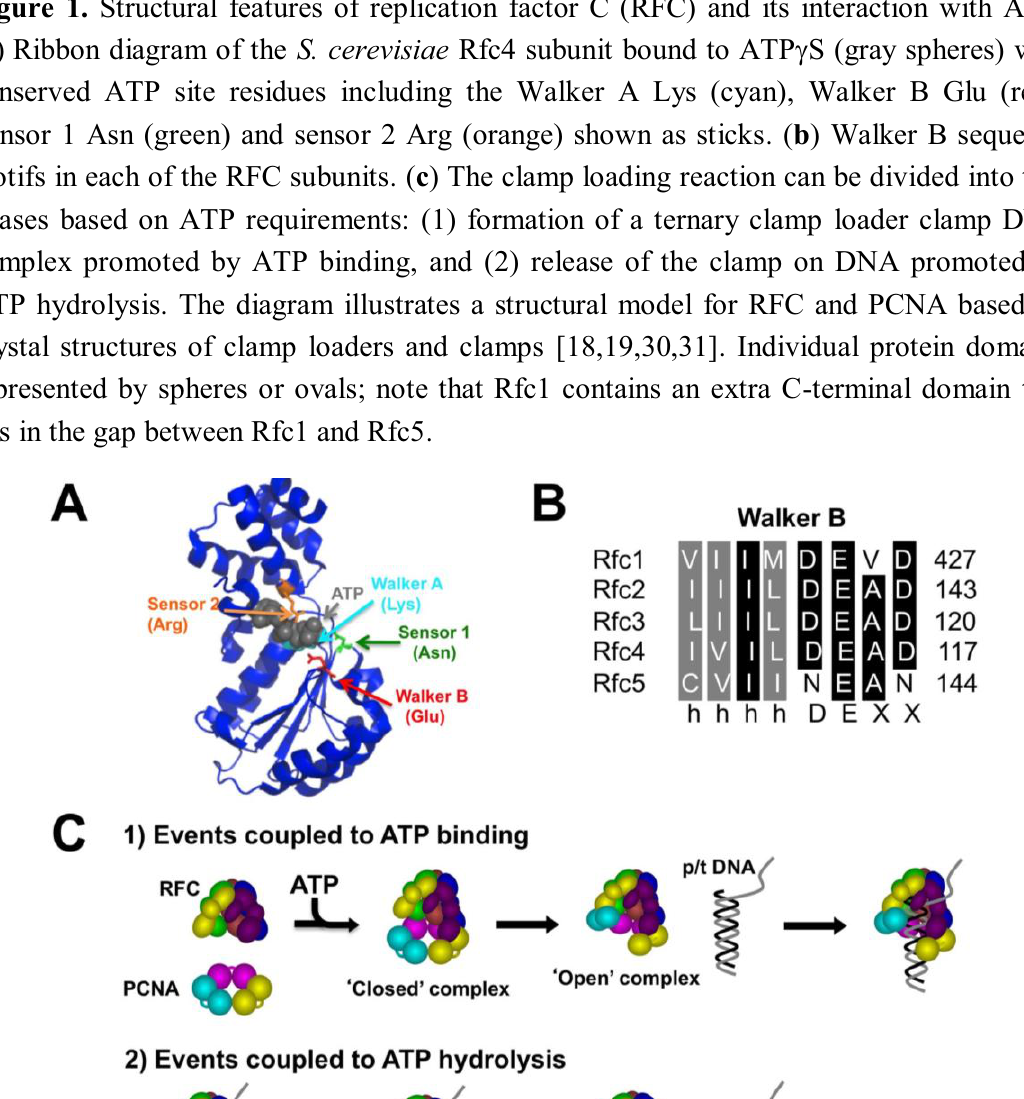
Figure 1. Structural features of replication factor C (RFC) and its interaction with ATP. ( a ) Ribbon diagram of the S. cerevisiae Rfc4 subunit bound to ATP (cid:74) S (gray spheres) with conserved ATP site residues including the Walker A Lys (cyan), Walker B Glu (red), Sensor 1 Asn (green) and sensor 2 Arg (orange) shown as sticks. ( b ) Walker B